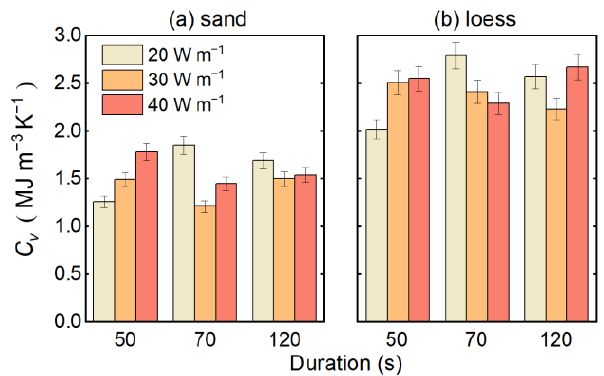
Figure 7. Fitting curve of the loess ρ b at a height of 12.5 cm.